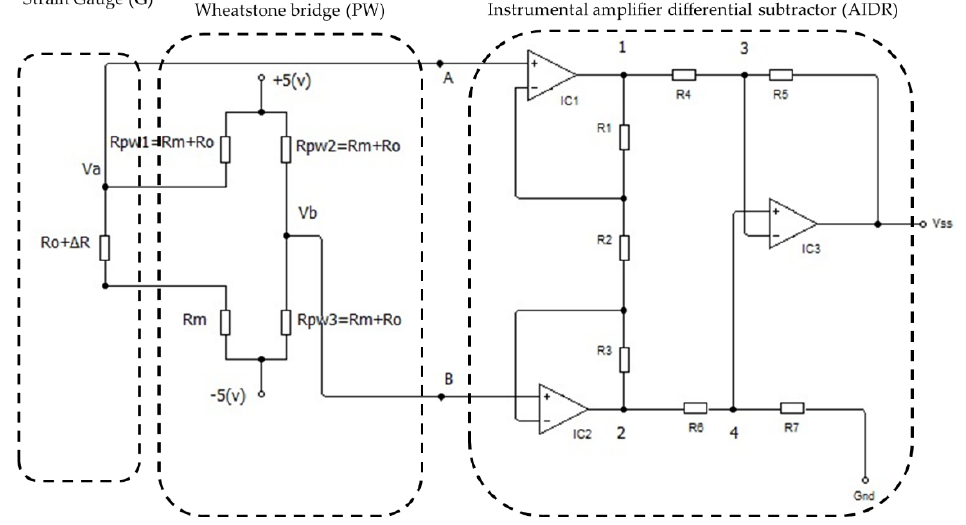
Figure 2. Scheme of the instrumental signal measurement during bending tests.